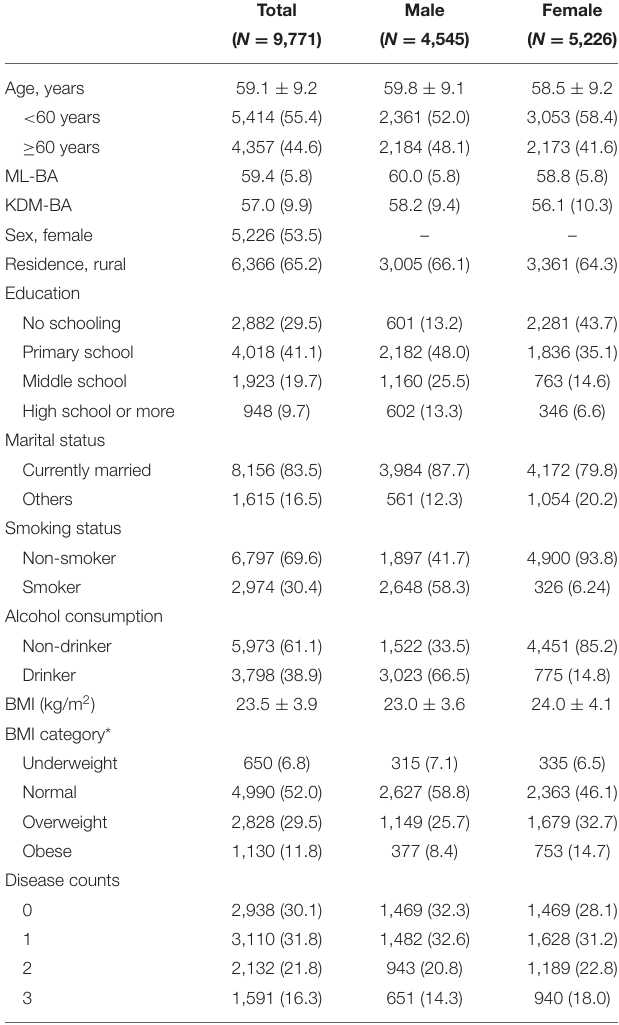
TABLE 1 | Baseline characteristics of the study population. TABLE 2 | MAE, MSE, RMSE, and R-squared value of machine learning models. Model MAE MSE